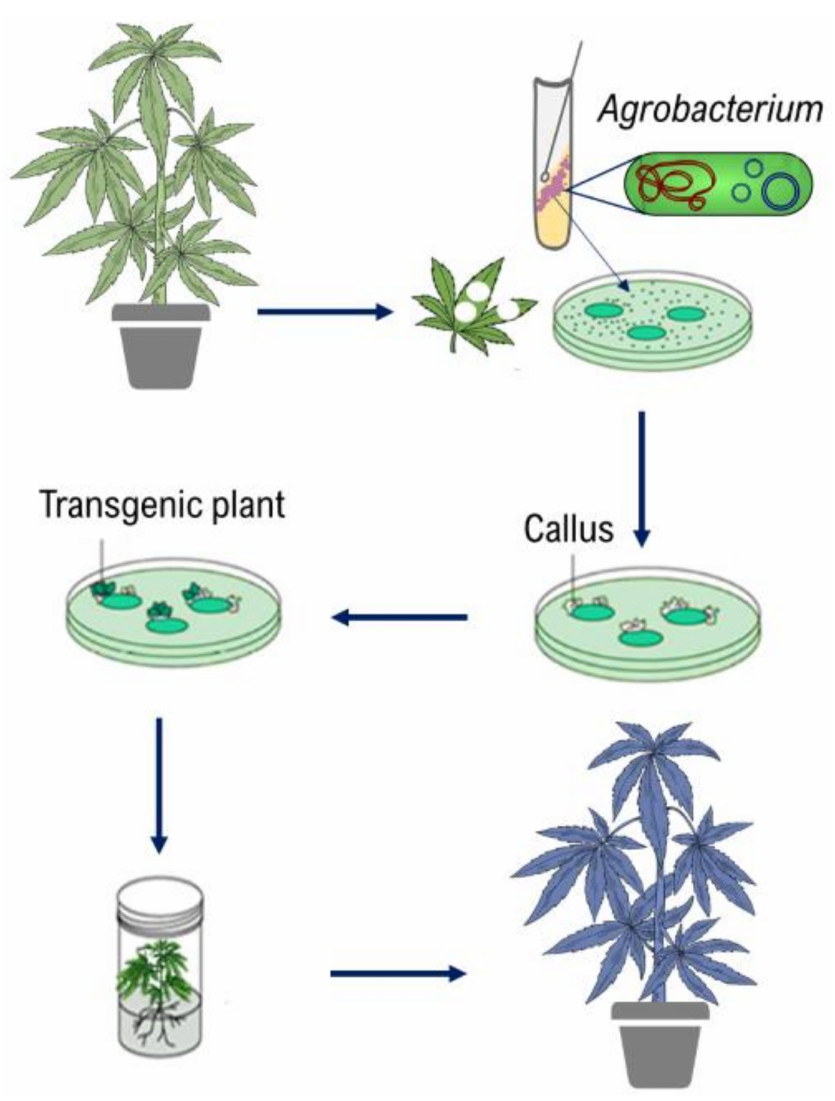
Figure 6. The schematic diagram of Agrobacterium -mediated gene